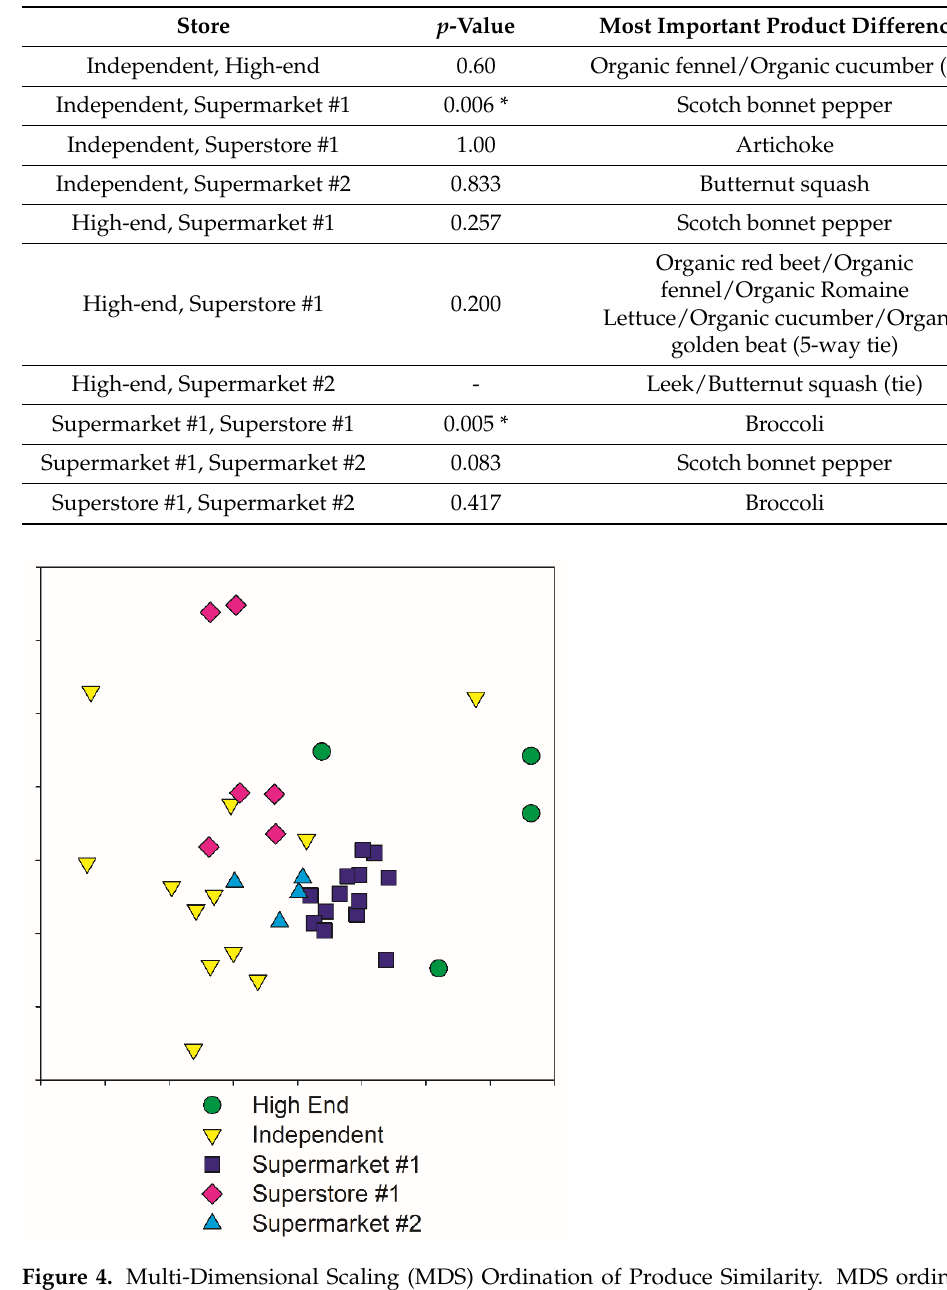
Figure 4. Multi-Dimensional Scaling (MDS) Ordination of Produce Similarity. MDS ordination representing the community at each supermarket. Bray–Curtis Dissimilarity values can be thought of as analogous to distance. The chart is generated by resampling multivariate space until a layout most closely representing the distances between all possible pairs of points is found. Thus distance between points is proportional to dissimilarity; the closer two points are, the more similar their assemblage of produce. Note that most store classification occupy their own distinct clusters, indicating greater similarity to each other than to the produce assemblages of others. The tighter clustering of stores like Supermarket #1 and Supermarket #2 indicate low variation between stores, whereas the larger spread of stores like Superstore #1 indicate less consistency in produce between locations. Stress (a measure of how well multivariate data is represented in two-dimensional space) for this ordination was 0.17, indicating a good representation of the data [24].